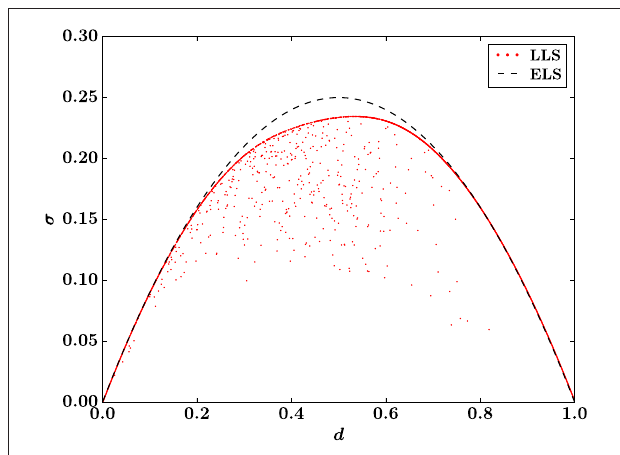
FIGURE 1 | Stress σ vs. damage d in the equal load sharing (ELS) fiber bundle model and the local load sharing (LLS) fiber bundle model on a square lattice. The ELS curve has been calculated analytically via Equation (1), and the LLS result is a simulation of a single sample ( N = 2,048 2 ). For clarity, the LLS result shows only every 2500th data point. The threshold distribution is uniform on the unit interval for both